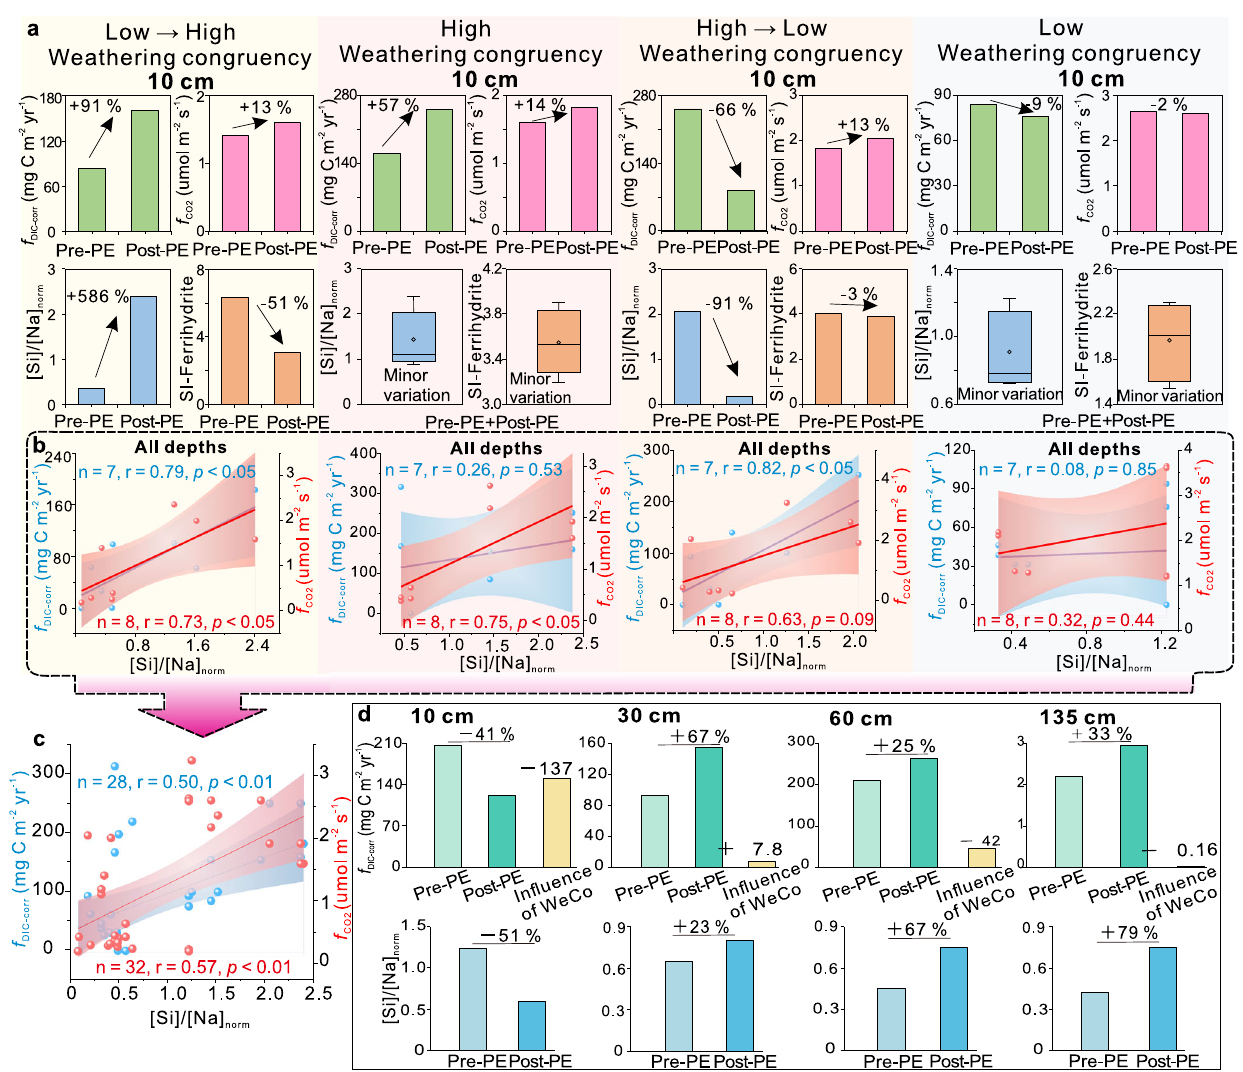
fl uxes ( f CO2 ) vs. [Si]/[Na] norm for the four weathering congruency groups. c Crossplotsoforganicmatterdecompositionrate f DIC-corr and f CO2 vs.[Si]/[Na] norm usingacompileddatasetfrom( b ). d Directin fl uenceofweatheringcongruencyon the priming effect. For each depth, the periods for evaluation were selected from Fig. 3 and Supplementary Figs. 7 – 9 based on similar changes in DOM optical properties to that of “ fresh ” DOM-induced priming-effect periods without notable change in weathering congruency. f DIC-corr generally covaries positively with weathering congruency. For example, in the topsoil, a 51% decrease of weathering congruency leads to a 41% decrease of f DIC-corr , resulting in ~137mgCm − 2 yr − 1 decrease of the priming